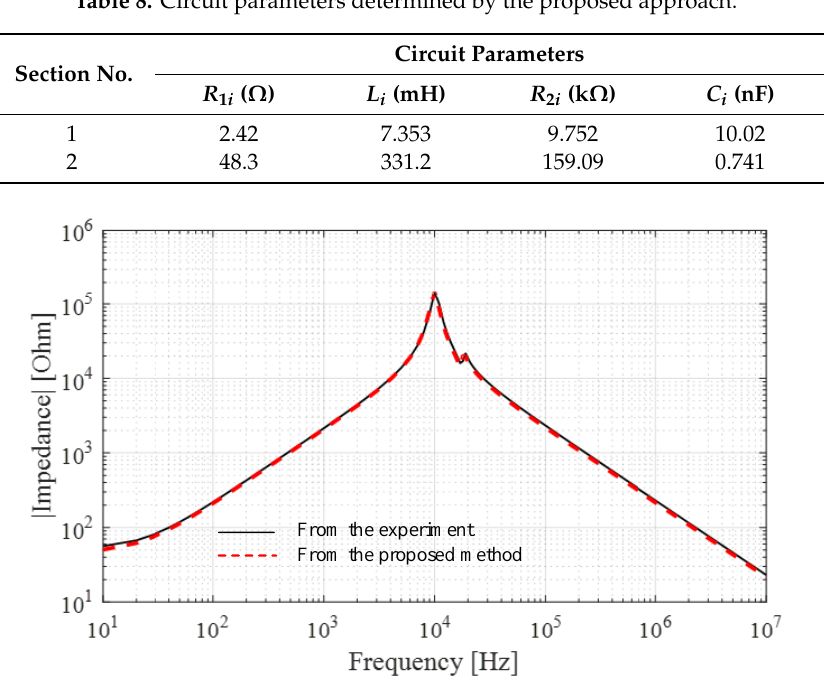
Figure 25. Magnitude of input impedances of the transformer winding from the measurement and the proposed method.